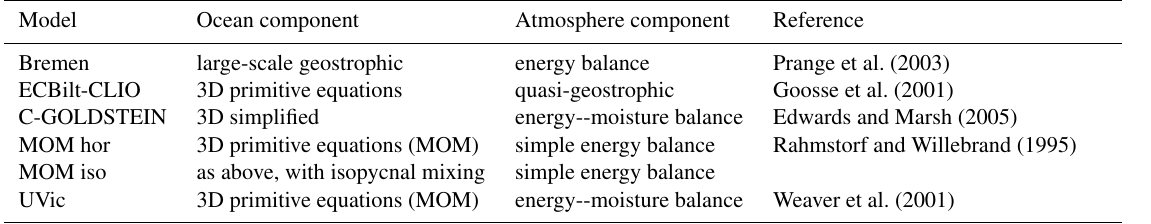
Table 1. Overview of models used. Each data point is independent of the others because each is the result of a quasi-steady-state run. The number of data points for each model was regridded onto a uniform freshwater forcing range consisting of 300 points. The summary of the type of model component and references are taken from Rahmstorf et al. (2005).